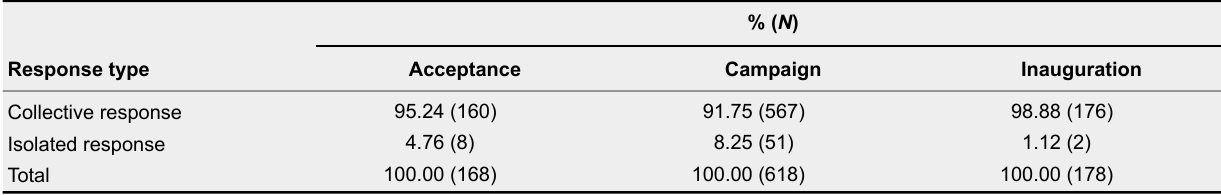
Collective and Isolated Response by the Three Speech Contexts